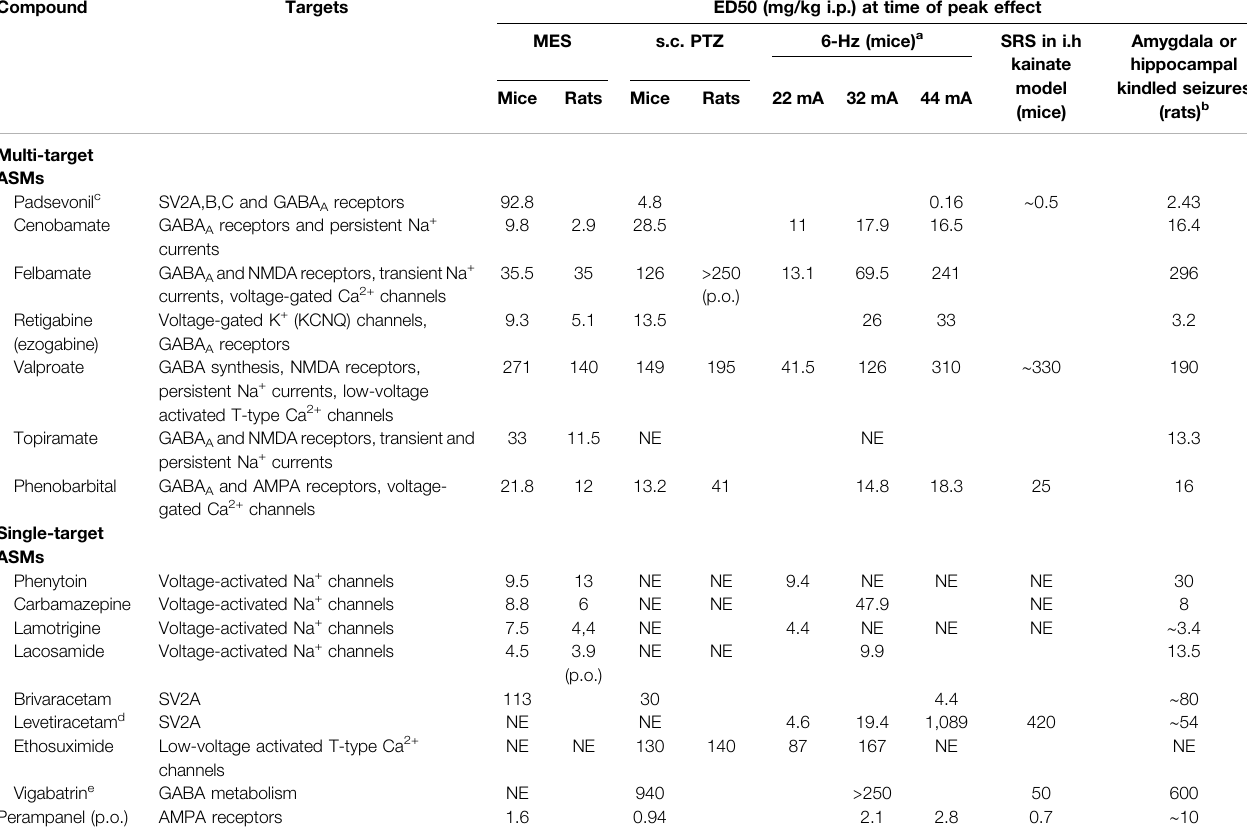
a Potency varies with mouse strain used. b For generalized convulsive seizures (ED 50 s are higher for focal seizures). c Not approved for treatment of epilepsy. d Note that levetiracetam also acts via other targets (see text). e Much more potent after chronic